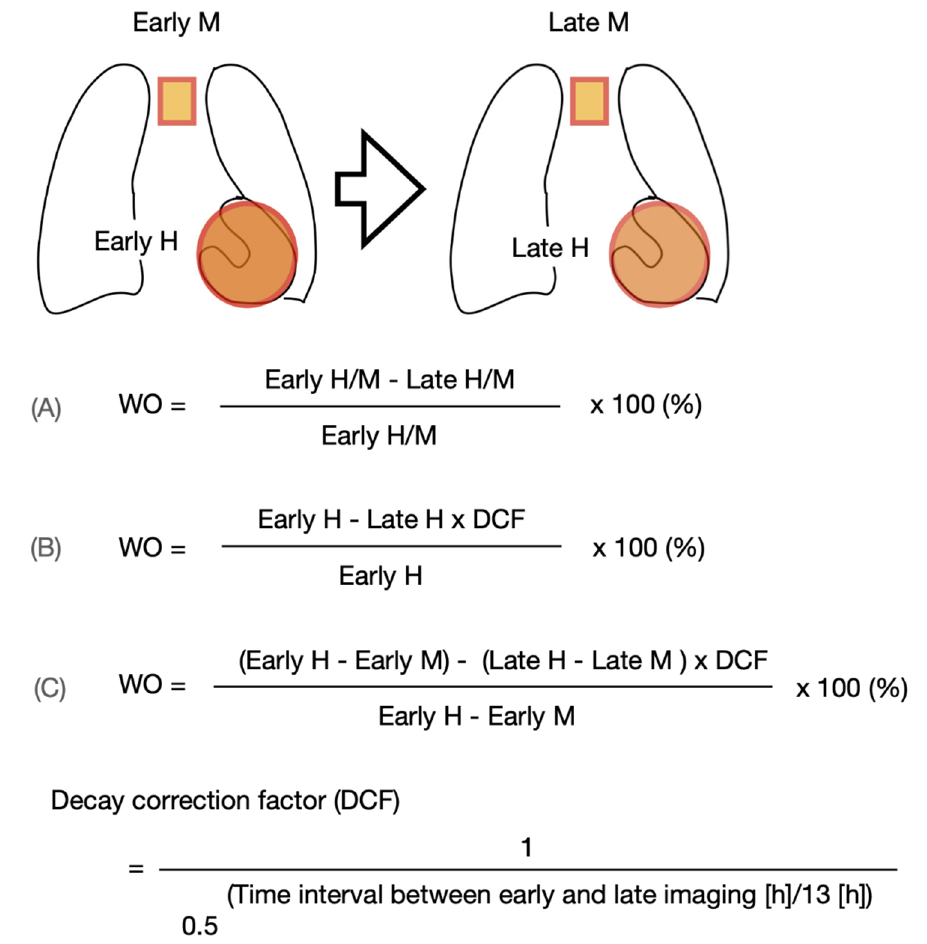
Figure 3. Variations of 123 I- m IBG washout (WO) calculation using the myocardial count densities requiring a time decay correction factor (DCF) without (B) or with background correction (C). Calculating the DCF value by the formula of 1/0.5 (time/13) for 3.0, 3.5 or 4.0 h, the DCF are 1.17, 1.21 and 1.24, respectively.